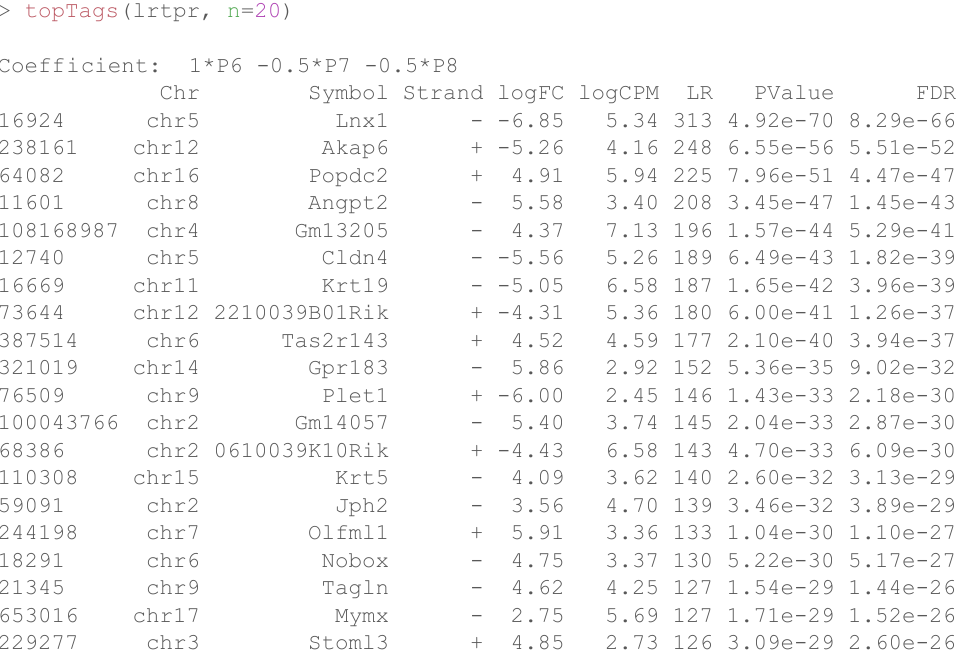
Here positive log-fold-changes represent gene promoters that have higher methylation level in the luminal population compared to the basal population. The Benjamini-Hochberg multiple testing correction is applied to control the false discovery rate (FDR).